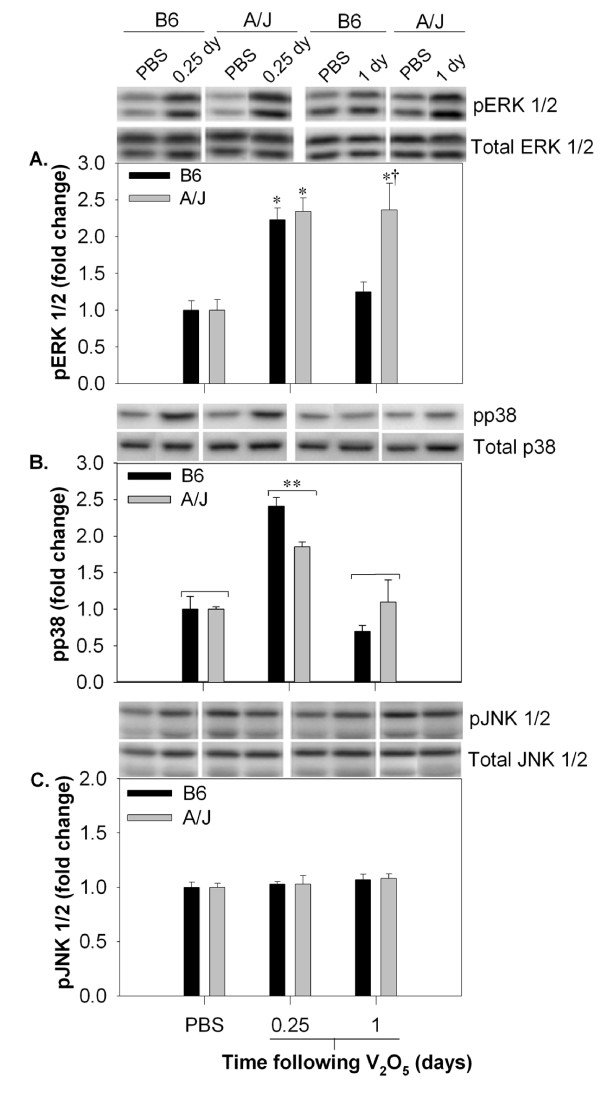
ERK1/2 is differentially activated in A/J compared to B6 mice following sub-chronic V2O5 instillation. Homogenates were prepared from the right lungs of mice A.) 6 hr and B.) 1 day after the last V2O5 exposure (n = 3-5/group). Phosphorylated and total levels of MAPK in lung homogenates were analyzed from 100 μg protein by Western blotting. Representative images and mean band intensities are representative of 2-3 independent experiments. *, significantly different than strain-matched PBS controls (P < 0.05). **, significant main effect of time. †, significantly different than time-matched B6 mice (P < 0.05).